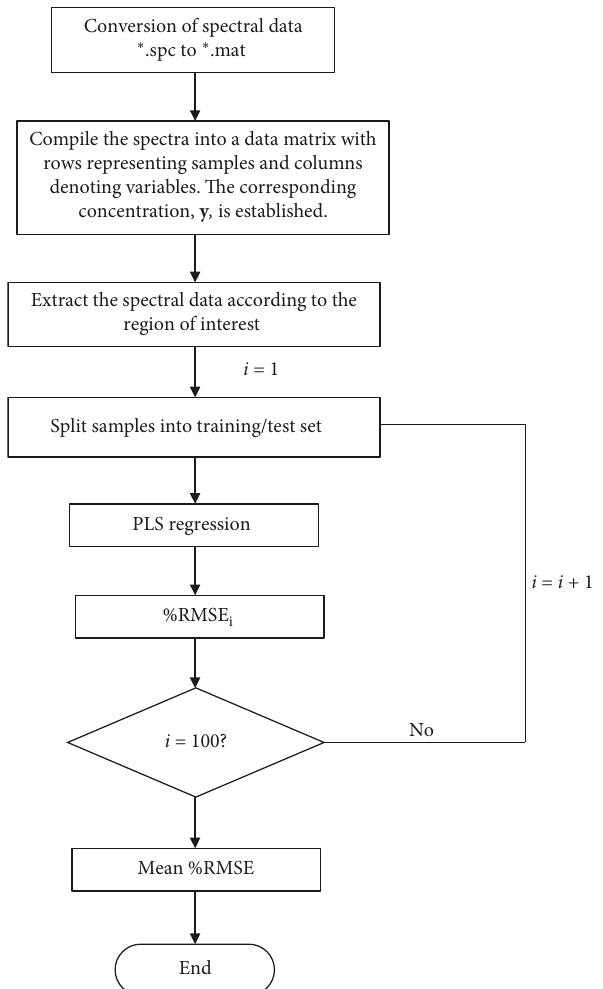
Figure 1: Flow chart of prediction of moisture in oil with